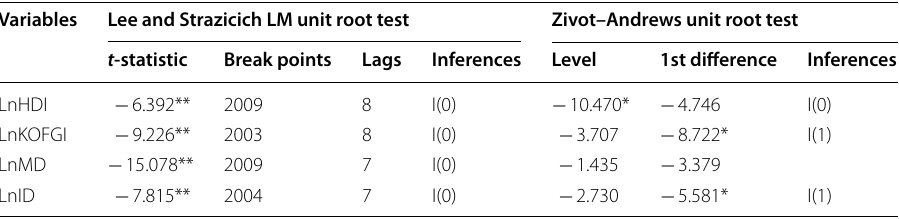
Table 6 Lee and Strazicich (2003) LM unit root test (one-break) and Zivot–Andrews structural break unit root test